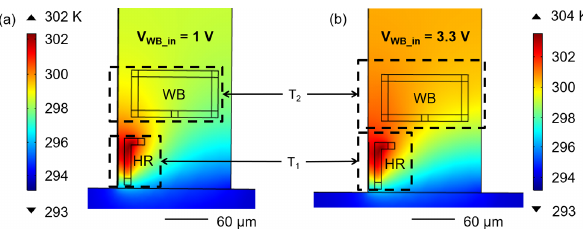
Figure 3. FEM for a thermally actuated cantilever sensor with (a) V WB_in = 1V and (b) V WB_in = 3 . 3V. The average temper- ature increase at the WB amounts to (cid:49)T = 2 . 23 ± 0 . 493K and 1 . 25 ± 0 . 480K in (a) and (b) ,